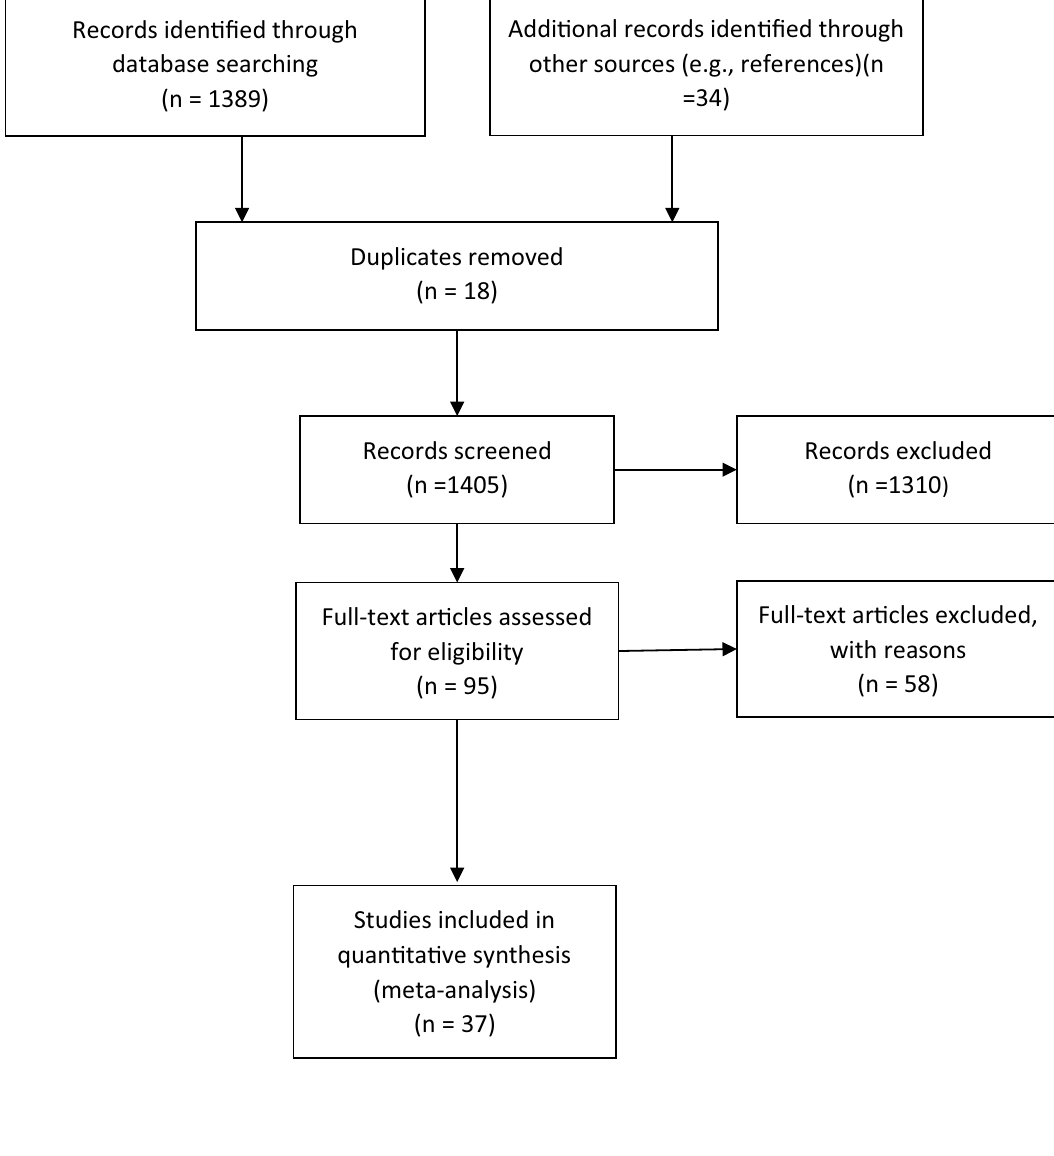
Figure 1. Literature review